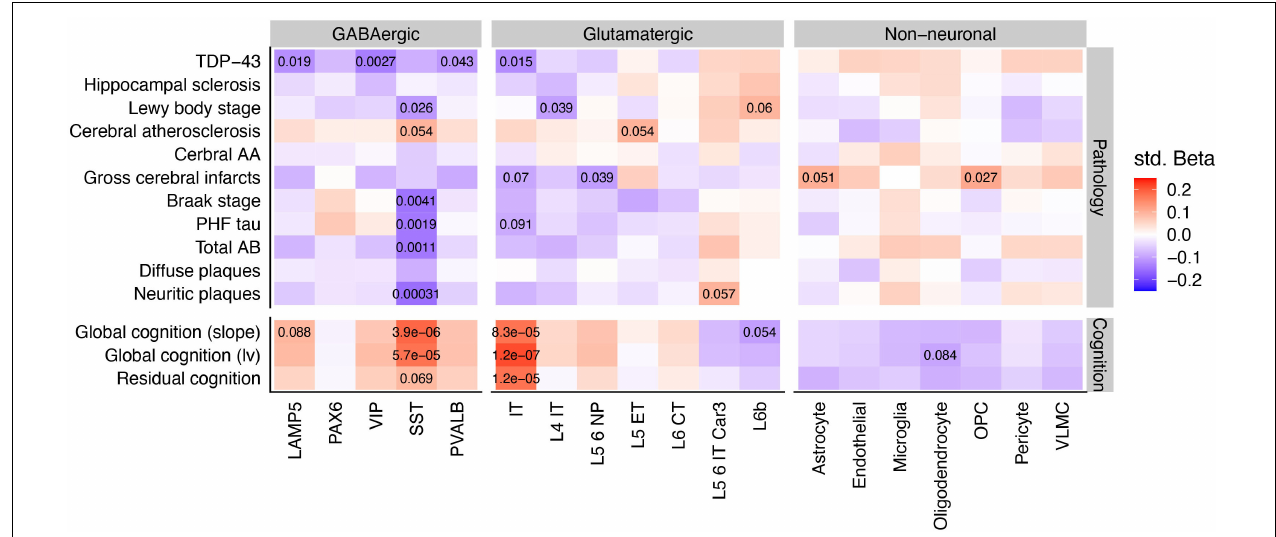
FIGURE 3 | Associations between cell type specific relative proportions and neuropathologies, cognition, and residual cognition. Inset values denote the FDR statistics of specific associations, where FDR < 0.1. Note that while pathology scores are coded such that greater levels of pathology indicate worsening brain health, global cognition scores are coded such that higher scores indicate better cognition and less dementia. Std Beta, standardized beta coefficients; PHF, paired helical filaments; AA, amyloid